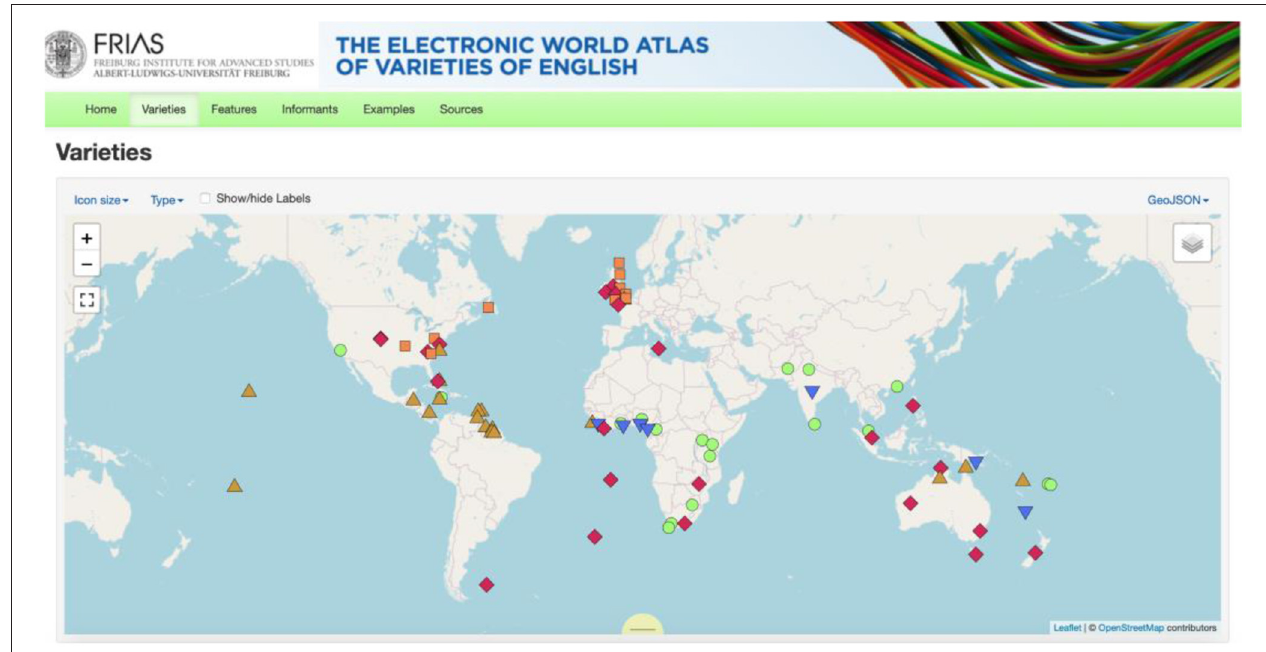
FIGURE 8 | eWAVE Atlas (from